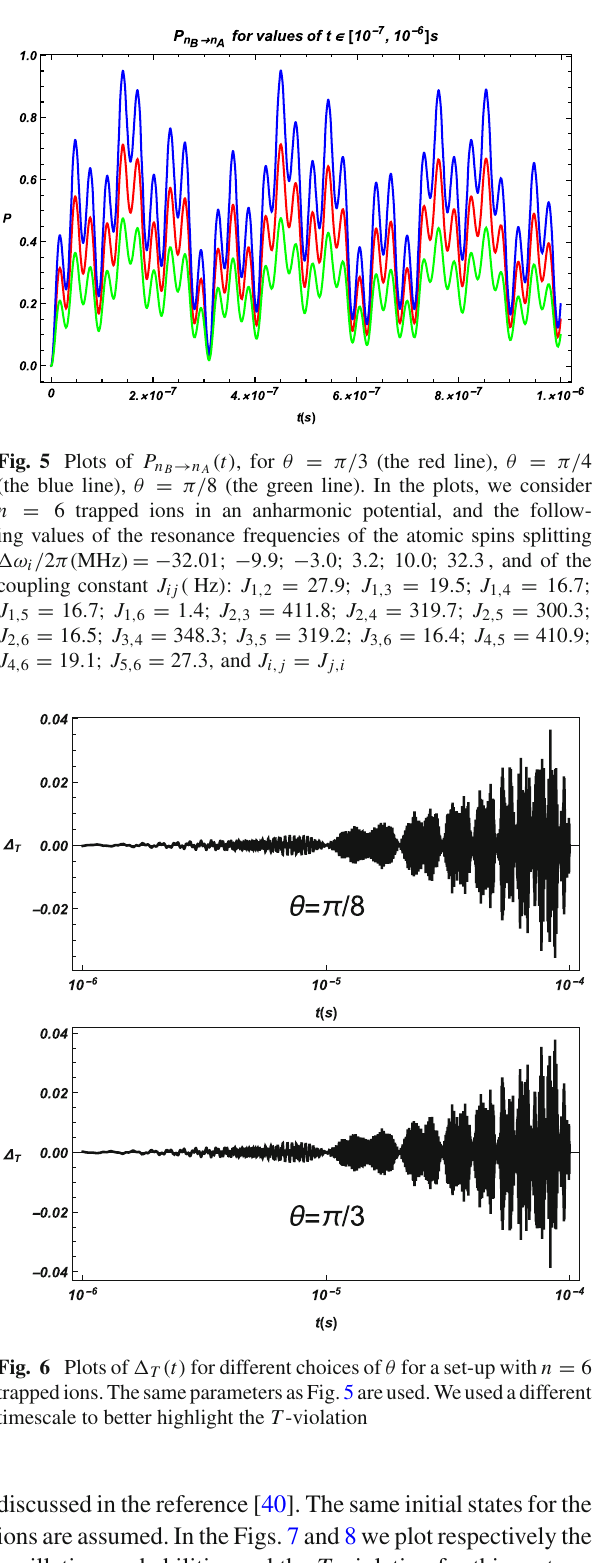
discussed in the reference [40]. The same initial states for the ions are assumed. In the Figs. 7 and 8 we plot respectively the oscillation probabilities and the T -violation for this system. It should be noted that the general prediction of Eq. (8) of the dependence of the T asymmetry on the total particle number N is confirmed by the plots shown above. The 6